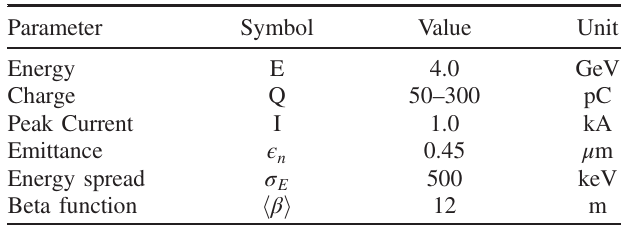
TABLE I. Parameters of the LCLS-II e-beam for generating soft x-rays.